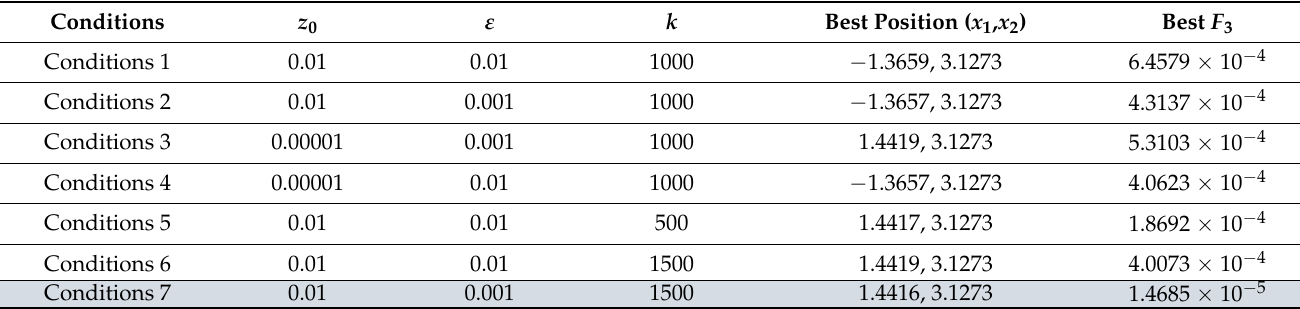
Table 6. Results of Case 3: F 3 at different